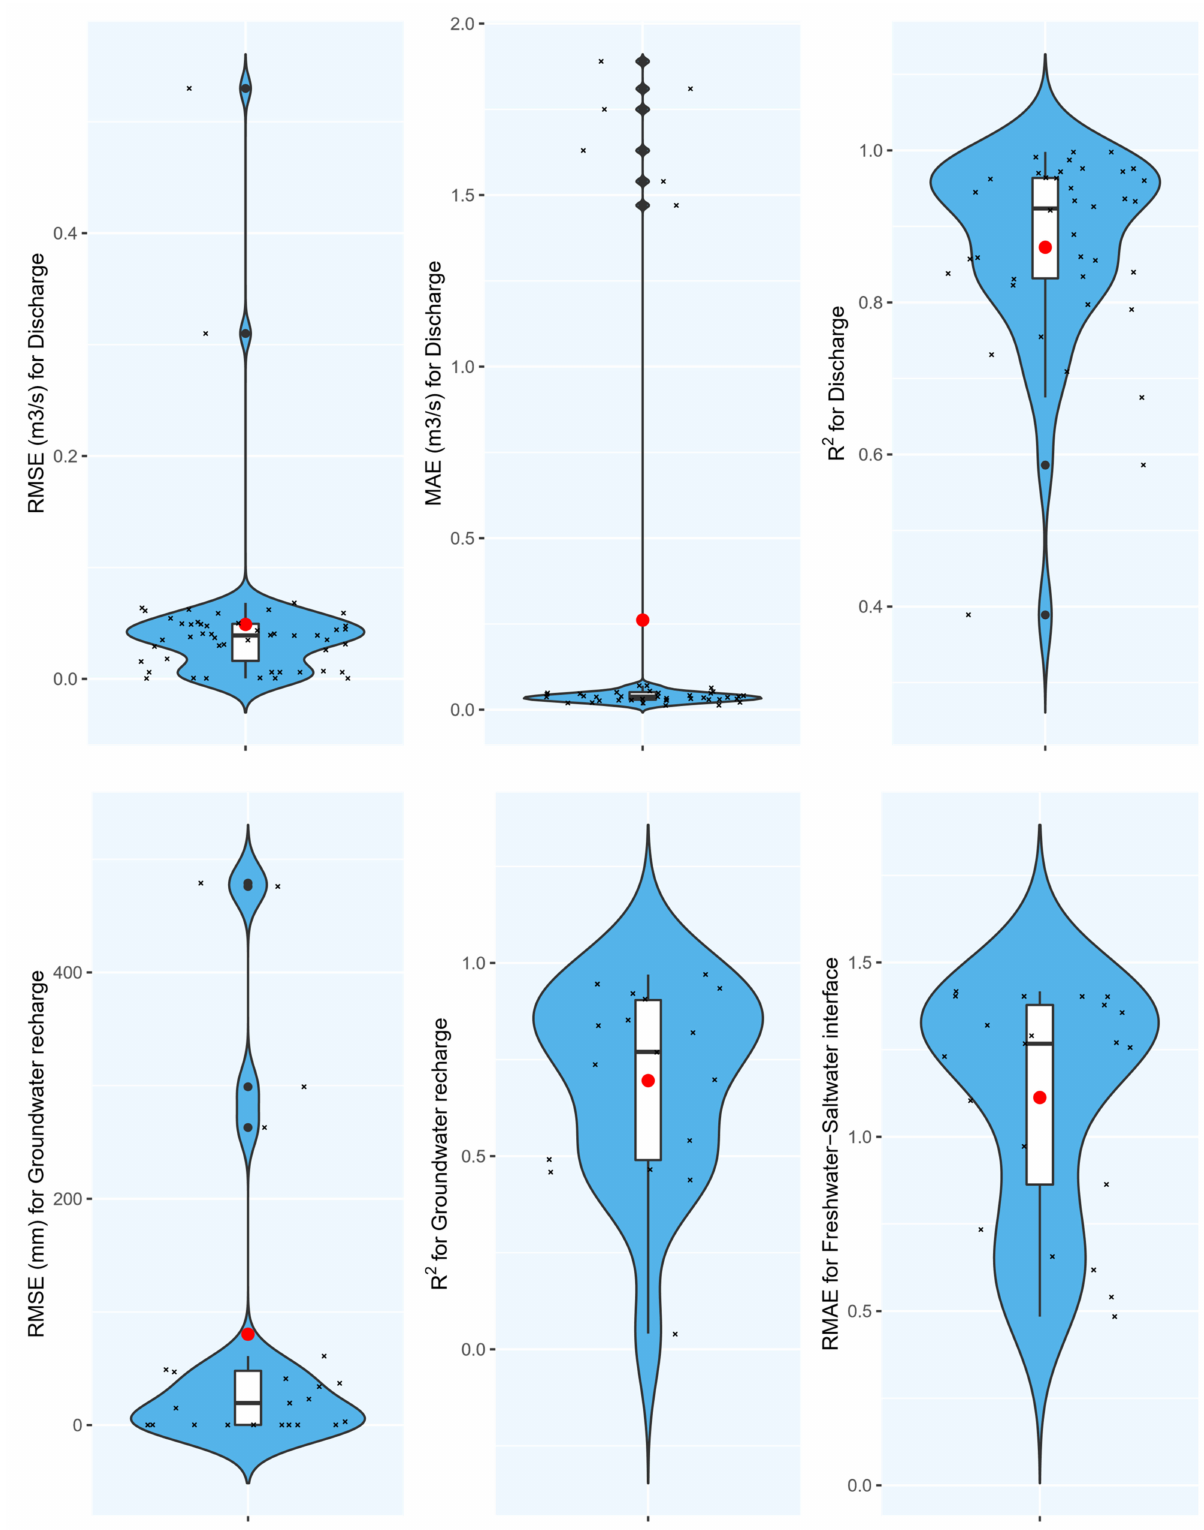
Figure 12. Results of meta-analysis for various groundwater